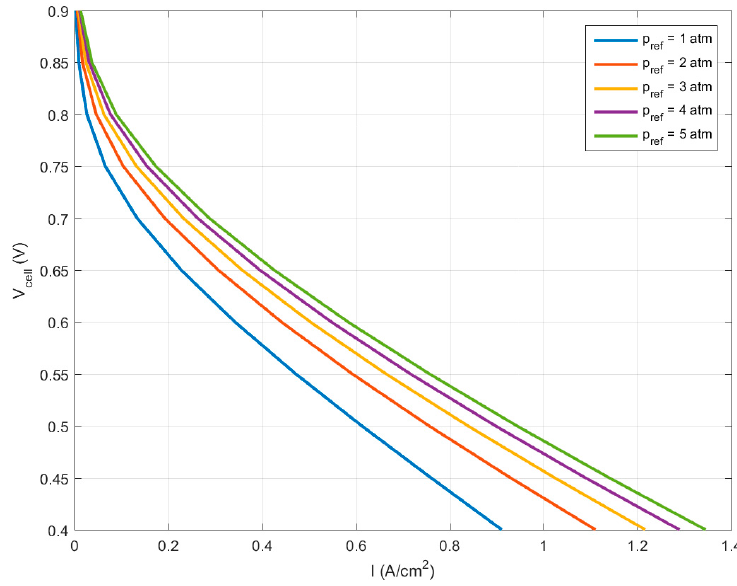
ff ect on the current density at T = 180 ◦ C, st Figure 5. Pressure effect on the current density at T = 180 °C, st (cid:2911) = 1.2 , st (cid:2913) = 2. Figure 5. Pressure e